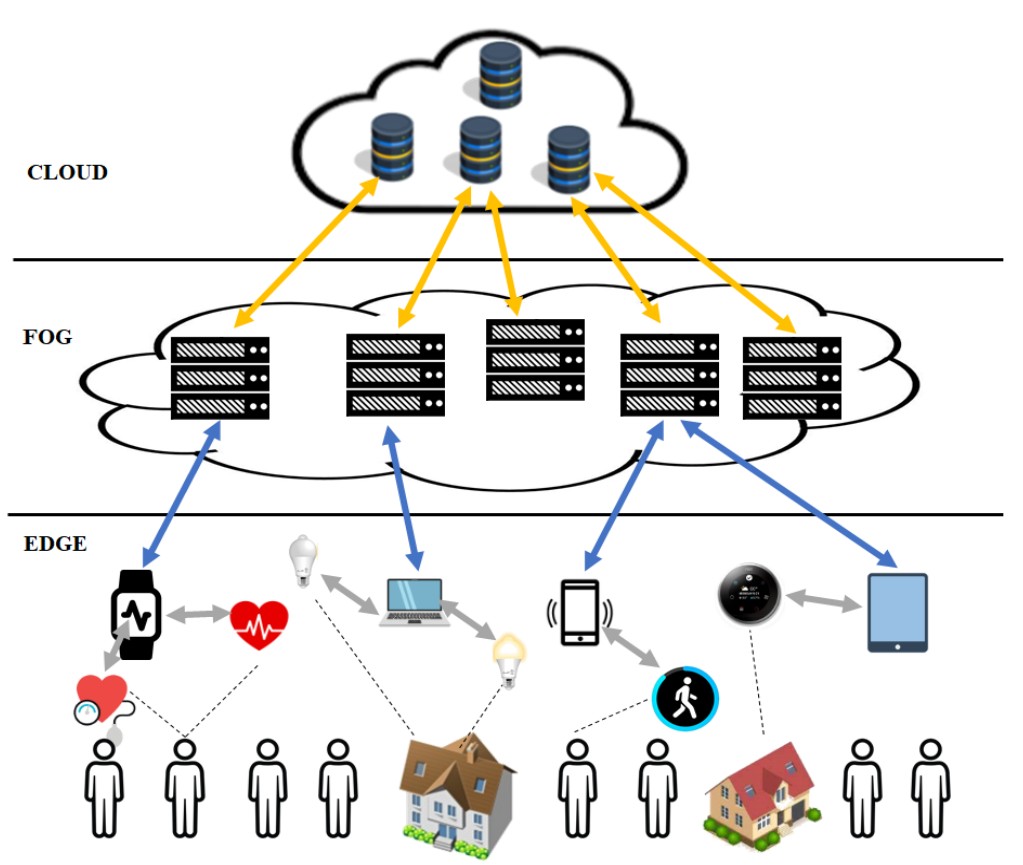
Figure 4. The relationship between edge (sensors), fog (nodes), and cloud (data centers/cloud services) computing in the context of pervasive healthcare Internet of Things.